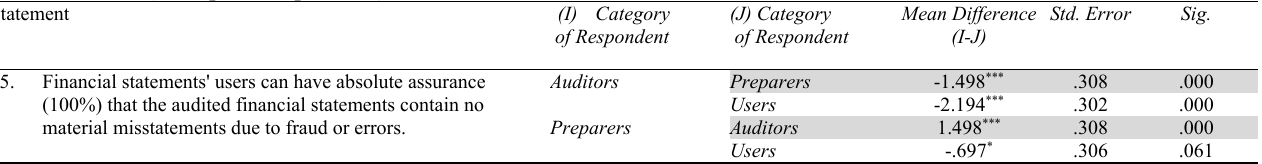
Post Hoc Tests (Multiple Comparisons) - Level of